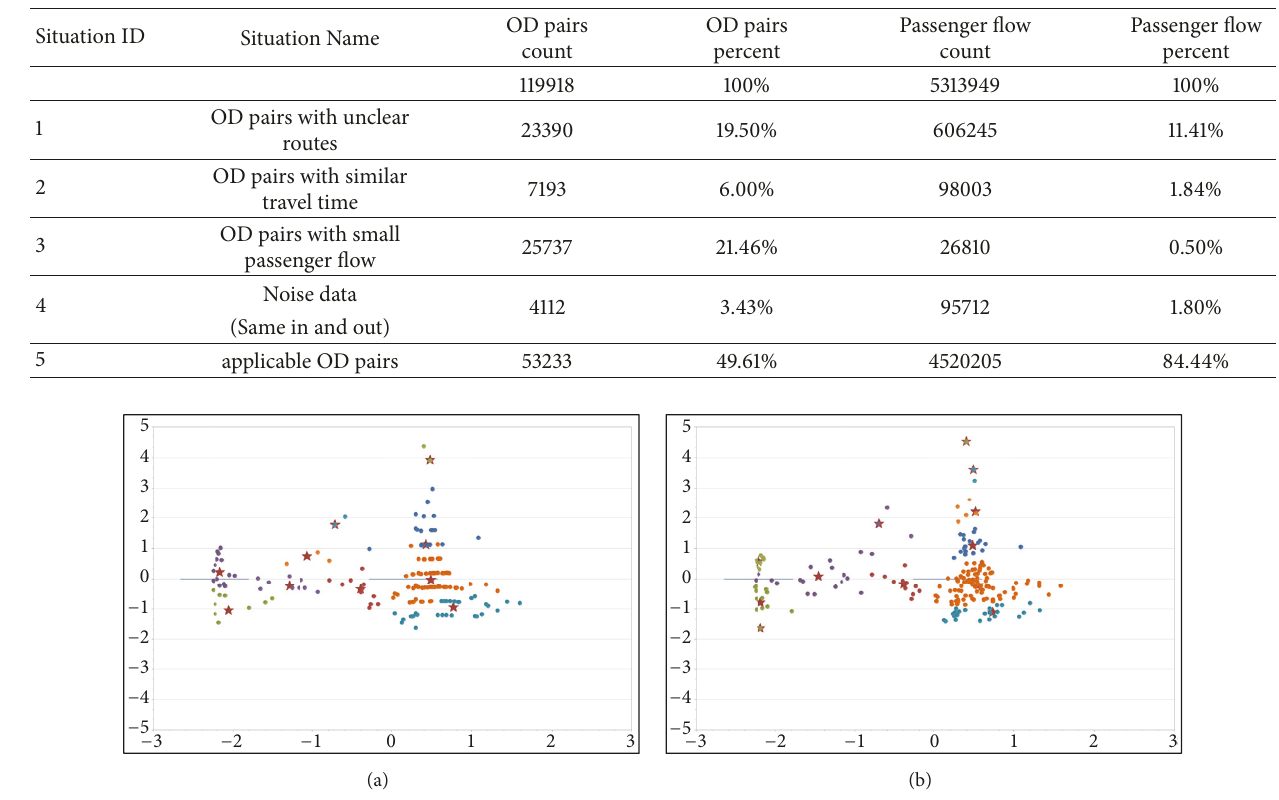
Table 6: Applicability of the proposed algorithm in Shanghai metro network.